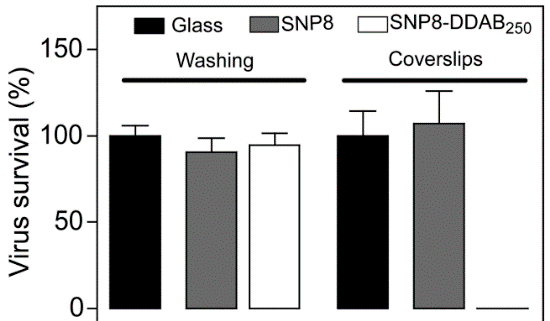
Figure 3. The antiviral effect of SNP80-didodecyldimethylammonium bromide as was tested by Lino et al. Republished with permission from Botequim D, Maia J, Lino MMF, Lopes LMF, Simões PN,